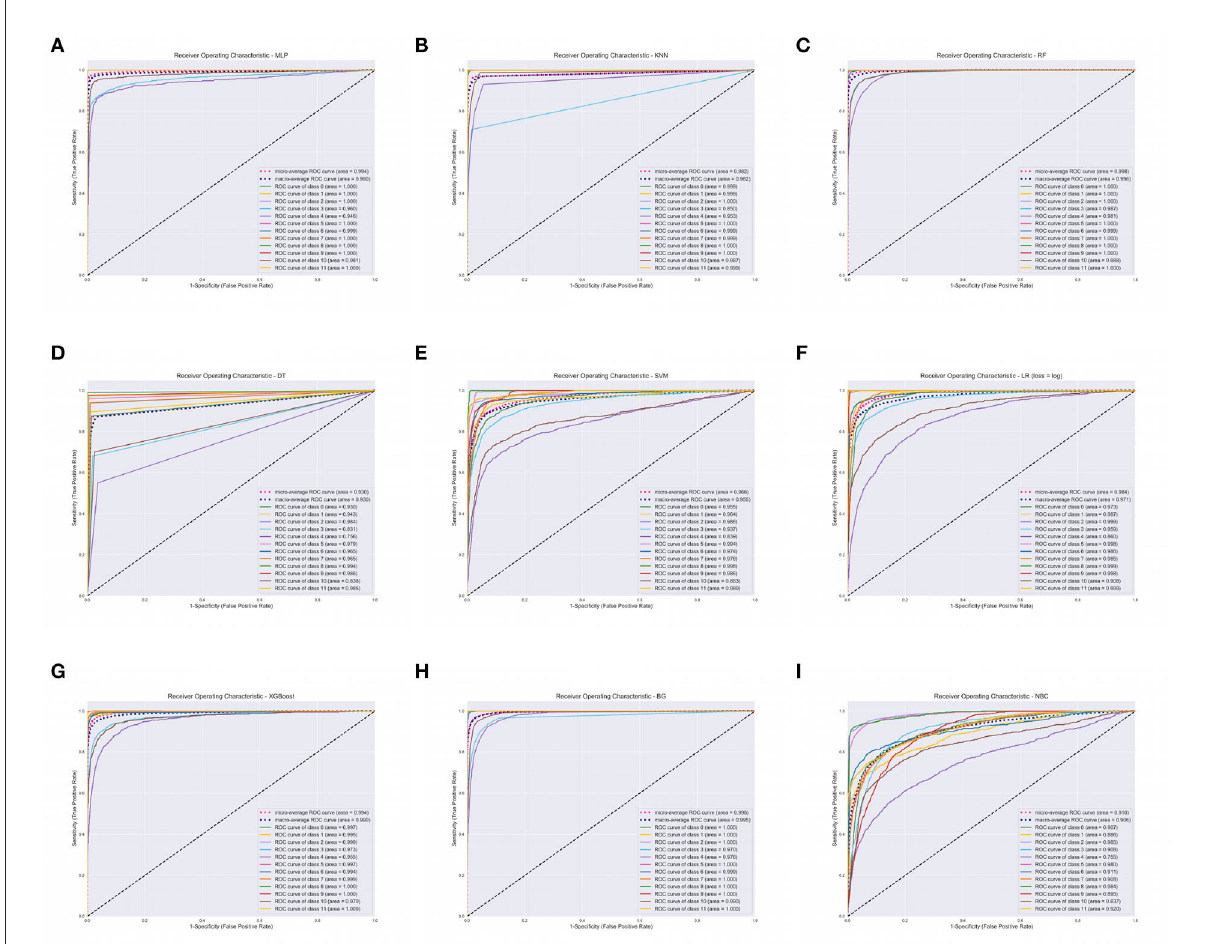
(H) AUROC for BG. (I) AUROC for BC. XGBoost, eXtreme Gradient Boosting; RF, Random Forest; ANN, Artificial Neural Network; KNN, K-Nearest Neighbor; SVM, Support Vector Machine; BG, Bagging; DT, Decision Tree; LR, Logistic Regression; BC, Bayes